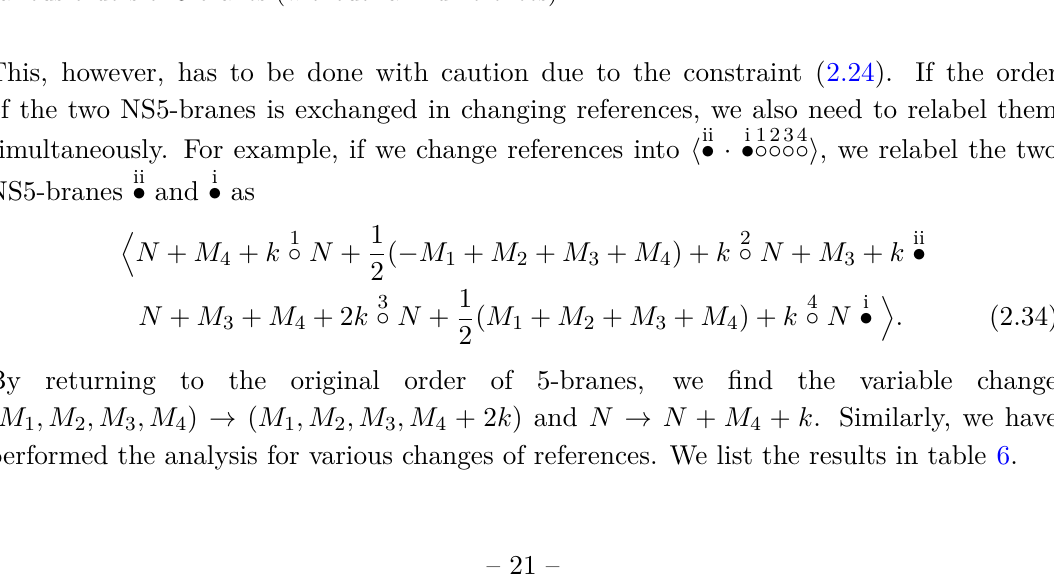
Table 5 . The parameters ( F 1 , F 2 , F 3 , G 1 ) and ( M 1 , M 2 , M 3 , M 4 ) for the brane configurations with various orders of 5-branes (without rank